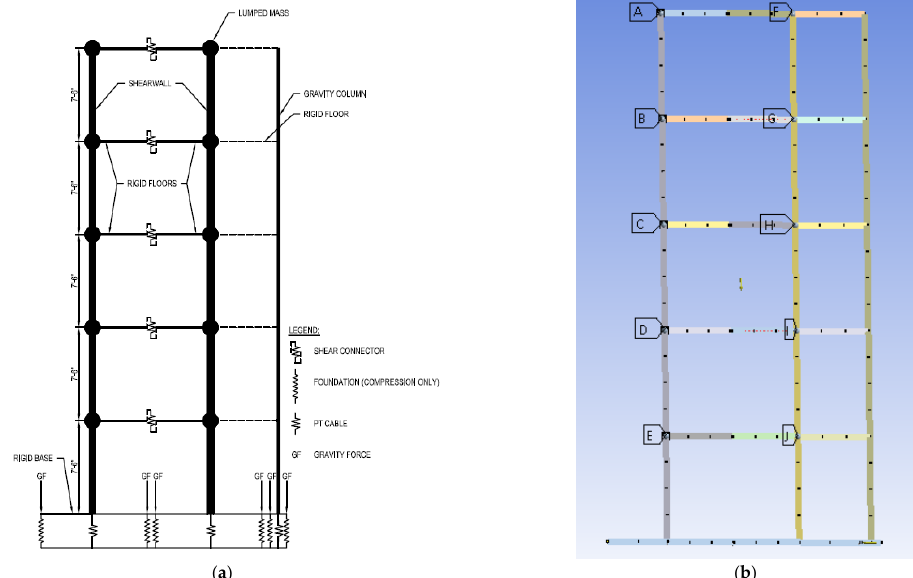
Figure 15. ANSYS building model: ( a ) concept model, ( b ) Ansys presentation (lumped masses are designated A through J).